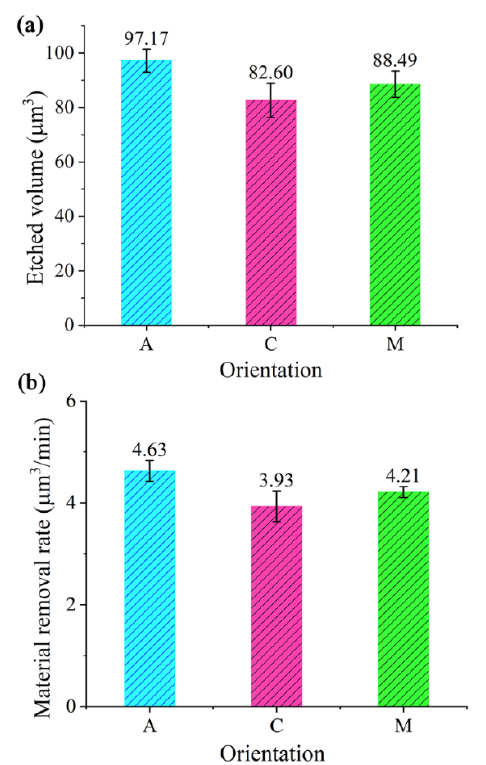
Figure 4. Etched volumes ( a ) and material removal rate ( b ) of the pits on A-, C-, and M-planes of sapphire.